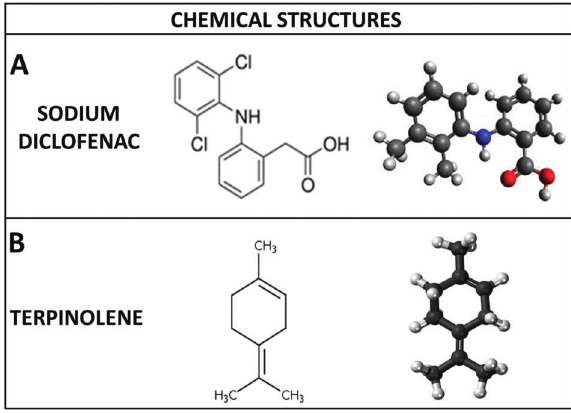
Figure 1. A , Sodium diclofenac. B , Monoterpene terpinolene (4-isopropylidene-1- methylcyclohexene) (Opdyke,